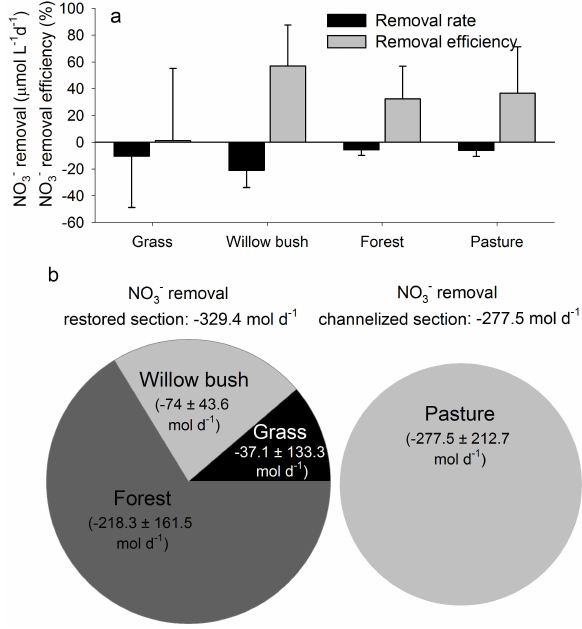
Fig. 4. (a) Average NO − removal rates and efficiencies with stan- 3 dard deviations ( ± ) derived by Monte Carlo simulations within a Fig. 5. Stable N (a) and O (b) isotope ratios ( δ 15 N, δ 18 O) of resid- specific FPZ during base/average flow conditions of the river during ual NO − in different riparian zones from all sampling campaigns. 3 spring to summer. The negative rate values designate loss from the In June and September 2008, as well as in June 2009 one week af- groundwater, most probably due to dissimilar consumption by den- ter a flooding event, an enrichment of 15 N and 18 O in the NO − itrification or due to plant uptake. (b) Nitrate loss rates ( ± standard observed in willow bush. Values from piezometers located in the deviations from Monte Carlo simulations) for the individual FPZs same zone were averaged and error bars represent standard devia- are normalized to the whole restored river section at base/average tions ( n > 2) or average deviations ( n = flow conditions of the river, and during the spring to summer pe- riod. For better comparison, we used the same aquifer volume for the channelized pasture area as for the total restored aquifer.